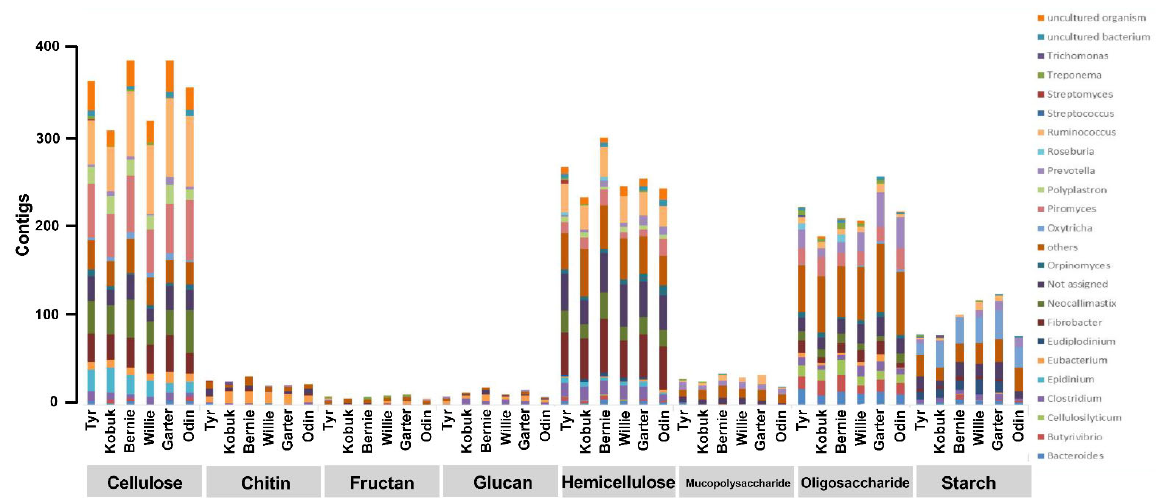
Figure 6. Putative microorganisms involved in the breakdown of cellulose, chitin, fructan, glucan, hemicellulose, mucopolysaccharide, oligosaccharide, and starch hydrolysis. Substrates degrading involved microorganisms were determined by the known activities of their original glycoside hydrolases. Phylotypes which were binned for less than ten contigs of glycoside hydrolases were included in the group of “others”, and the glycoside hydrolases without binned phylotypes were included in the group of “Not assigned”.